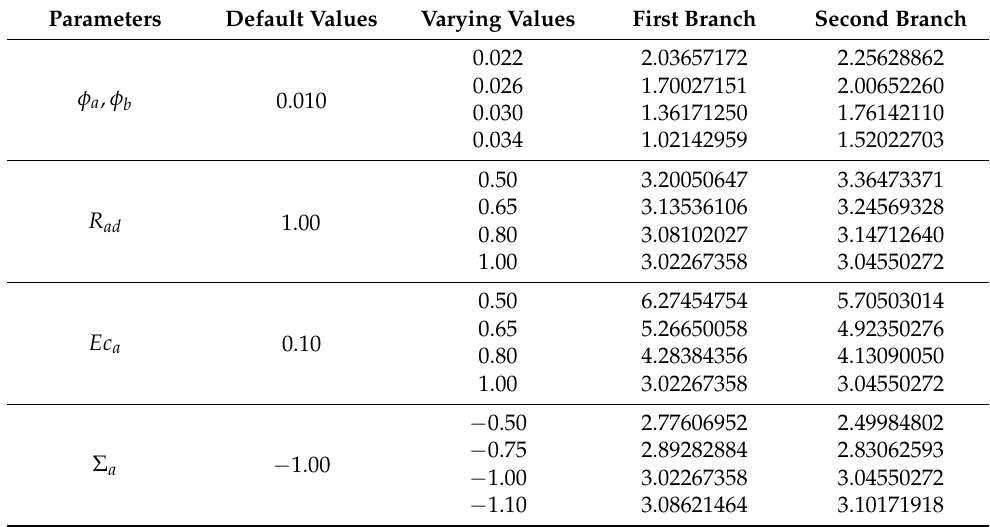
Table 4. Numerical values of the quantity Nu x for both the FBS and SBS results.